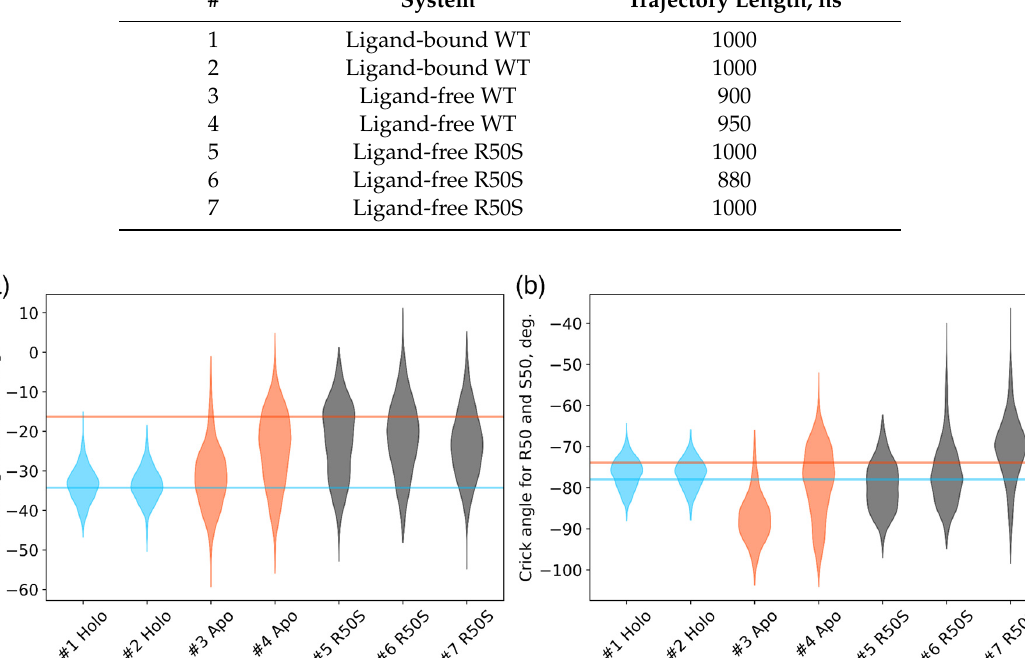
Figure 4. Distances between the backbone C α atoms of the residues Arg50 or Ser50 and Asp133 within each protomer in the last 200 ns of the simulations. For each trajectory, two distributions are shown, with each one corresponding to a single protomer. The distances are indicative of intact hydrogen bonds between Arg50 and Asp133 in the WT protein and broken hydrogen bonds between Ser50 and Asp133 in the R50S mutant. Vertical lines show the respective distances in the crystallographic structures: the values for the symmetric ligand-bound WT structure (PDB ID 5IJI) are shown in cyan, the values for the symmetric ligand-free WT structure (PDB ID 5JEQ) are shown in orange.